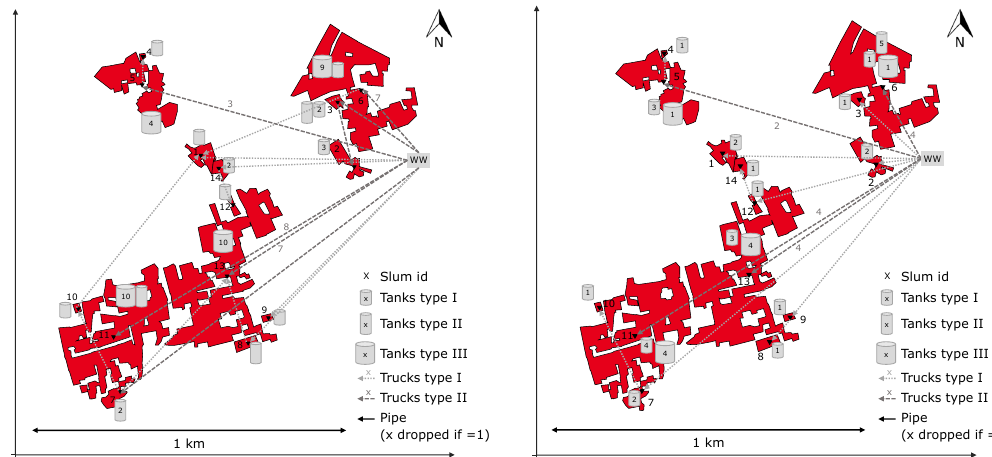
Figure 12. Optimization result for a slum cluster in Dhaka 2010, Bangladesh, with a population density of 100,000 people per km 2 (left) and 50,000 people per km 2 (right).